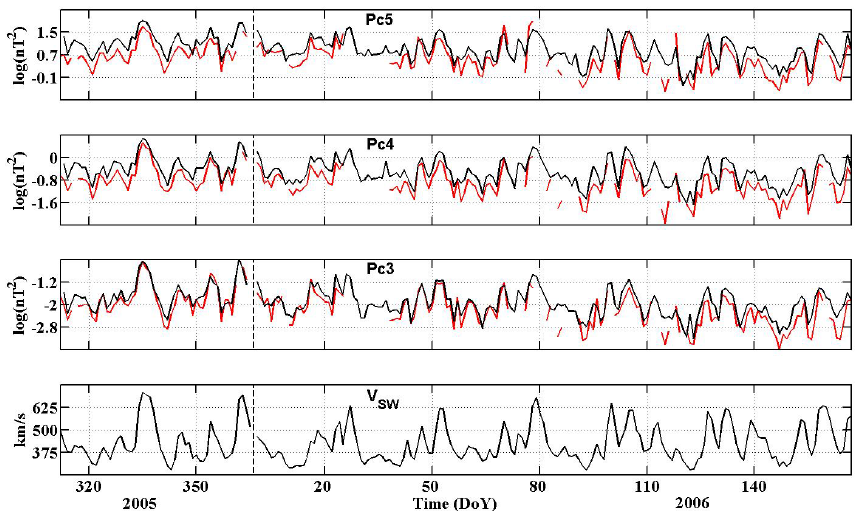
Fig. 2. 1-day averages of ULF power (log scale) at DMC (red line) and TNB (black line) and SW speed in the time interval 8 November 2005–16 June 2006. From top to bottom: Pc5 (1–7mHz), Pc4 (7–22mHz), Pc3 (22–100mHz) power of the horizontal component, SW speed V SW .